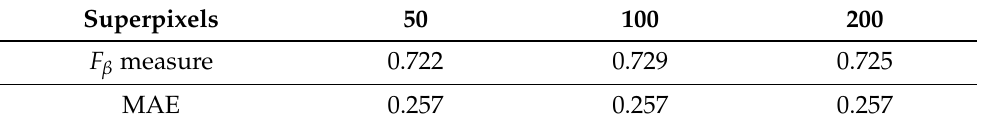
Table 8. Our model’s F β measure and MAE results for 50, 100 and 200 superpixels (ECSSD dataset).